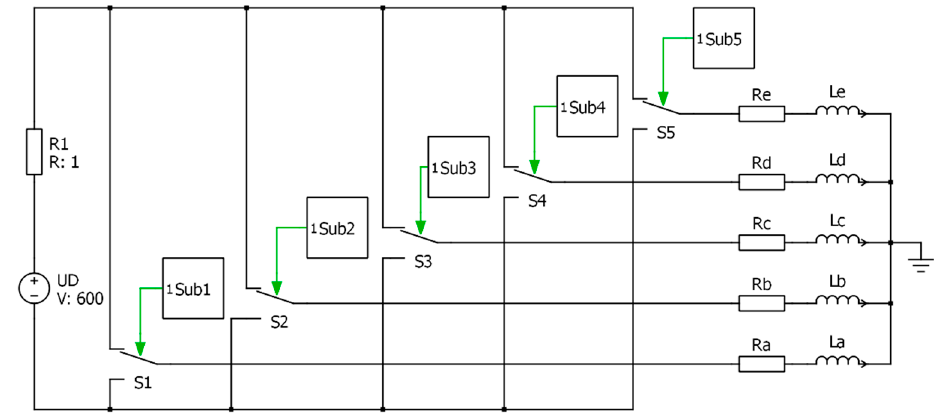
Figure 12. The model of the five-phase two-level inverter made in the PLECS program.